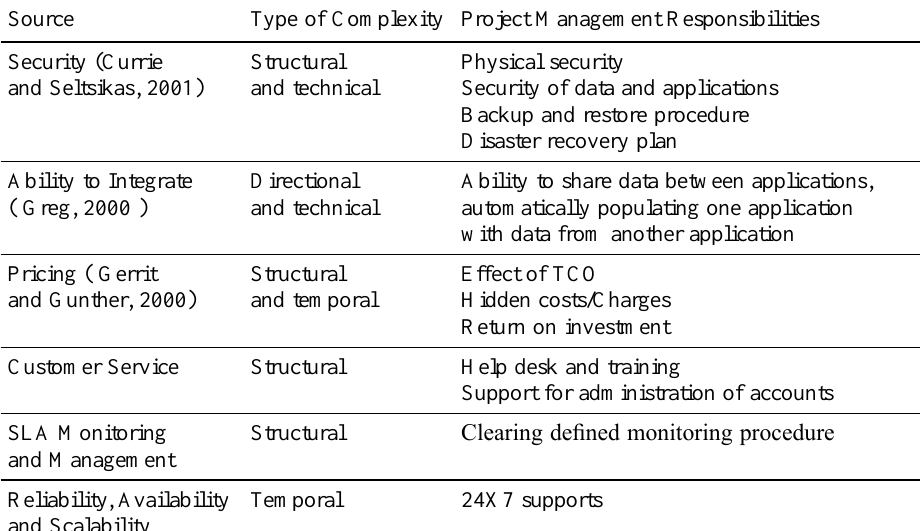
Table 3. ASP services and complexity